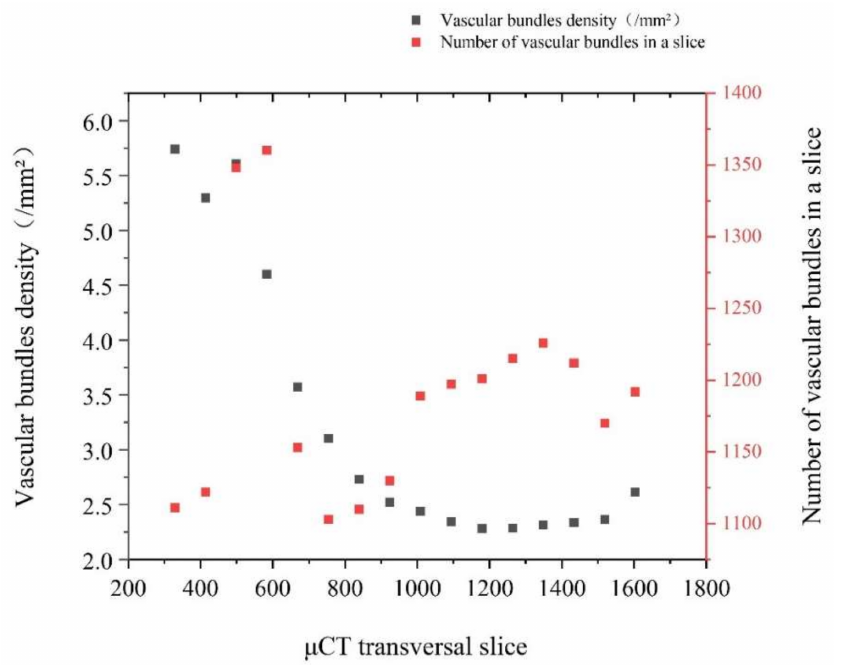
Figure 6. Variations of the number and frequency of axial vascular bundles at different heights of the bamboo